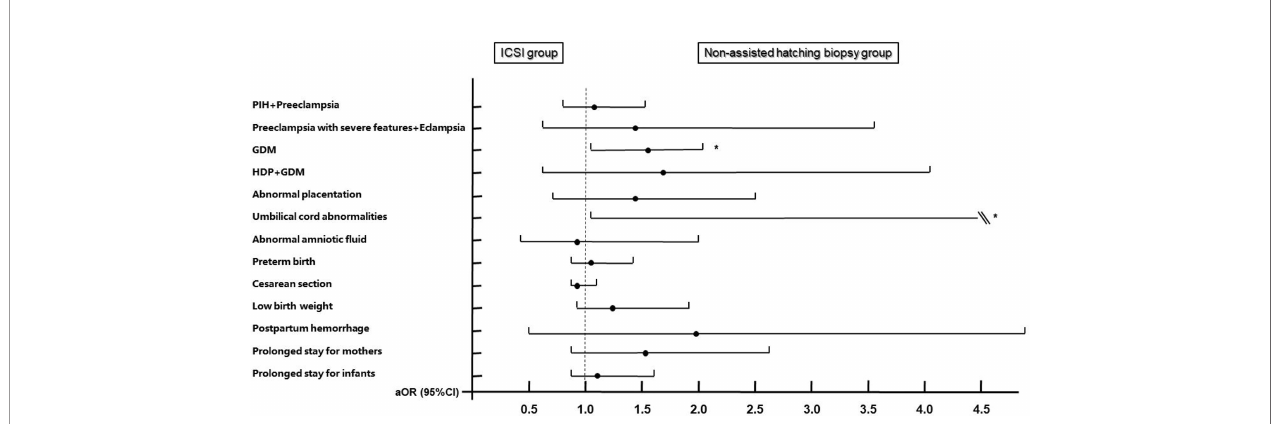
FIGURE 3 | Adjusted odds ratios and 95% con fi dence intervals for maternal and neonatal outcomes by embryo biopsy status. Adjusted for maternal age, maternal BMI, times of previous miscarriages, parity, endometrial preparation protocols, endometrial thickness of transfer day, hCG ratio, PCOS, thyroid disorders, chronic hypertension, family history of hypertension, diabetes, family history of diabetes, history of uterine surgery, and neonatal sex. ICSI group is the reference group. PIH, pregnancy-induced hypertension; GDM, gestational diabetes; HDP, hypertensive disorders of pregnancy. * Statistically signi fi cant.